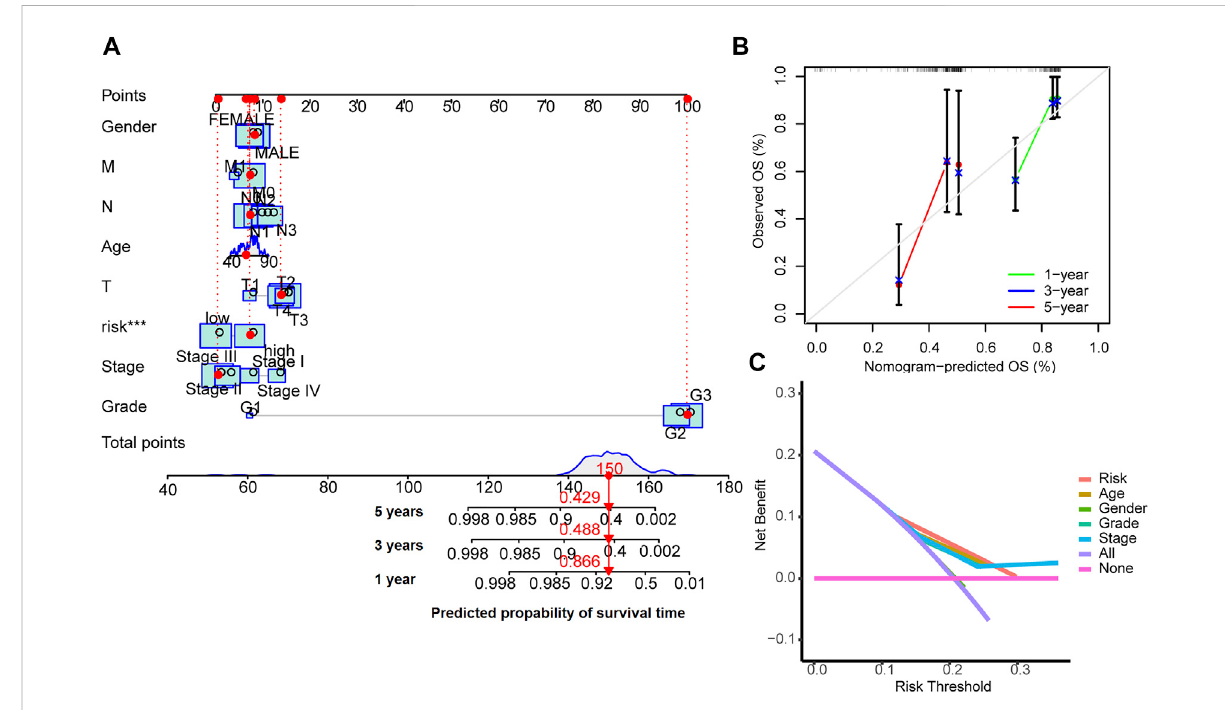
FIGURE 5 Nomogram for survival prediction (A) , the calibration curves (B) and the decision curves (C)